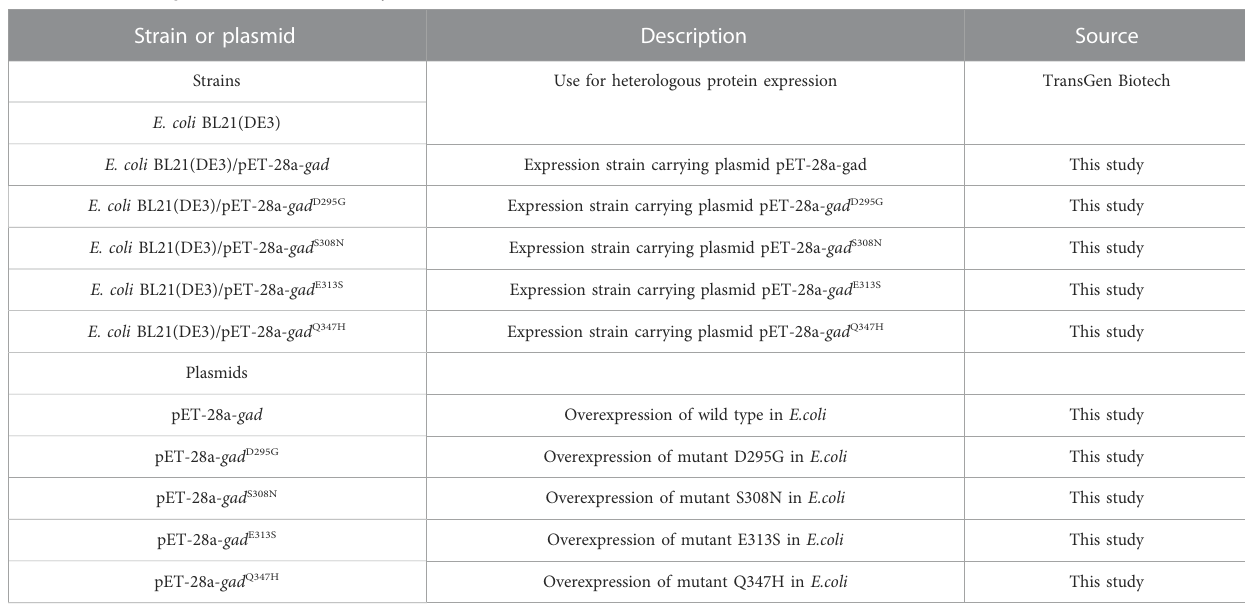
TABLE 1 Strains and plasmids used in this study.